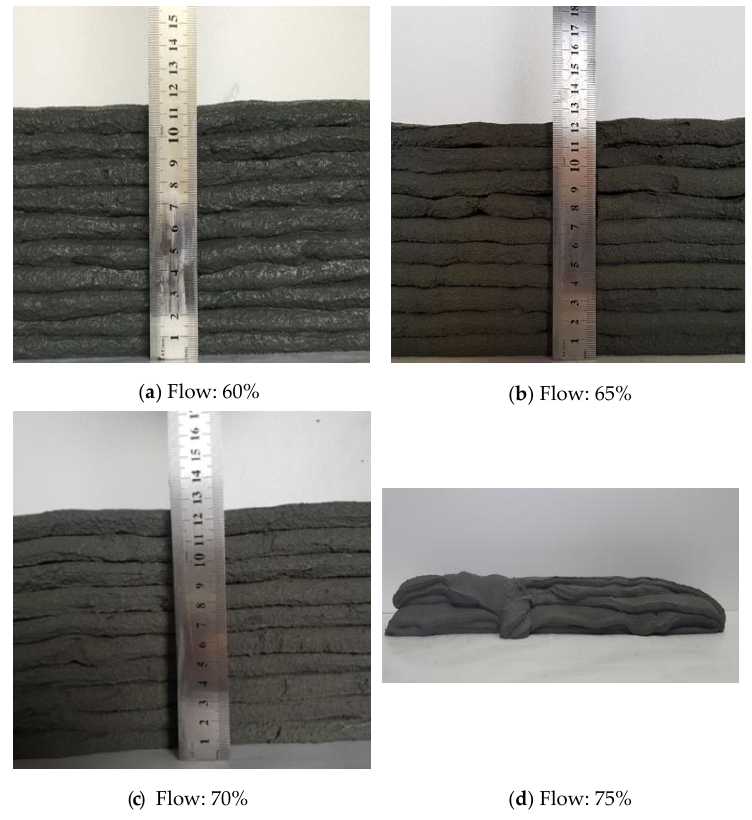
Figure 4. Test results of flow determination (SBR/cement ratio: 0.15).